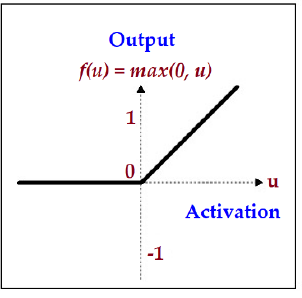
Figure 16. The Rectified Linear Unit ( ReLU) function.